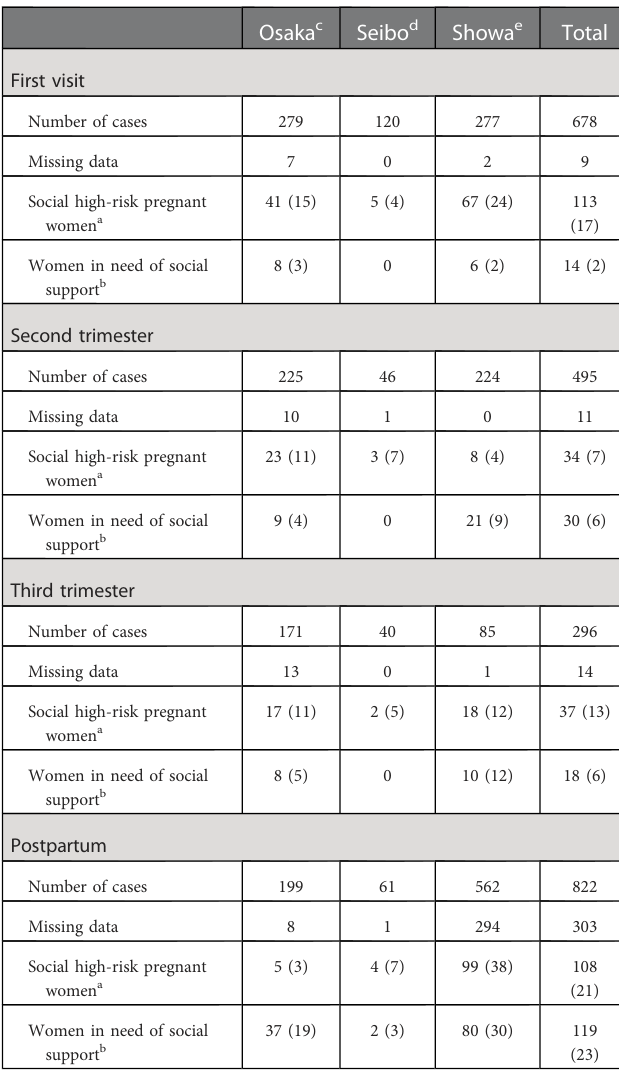
TABLE 2 The number of pregnant women in need of support by the public health